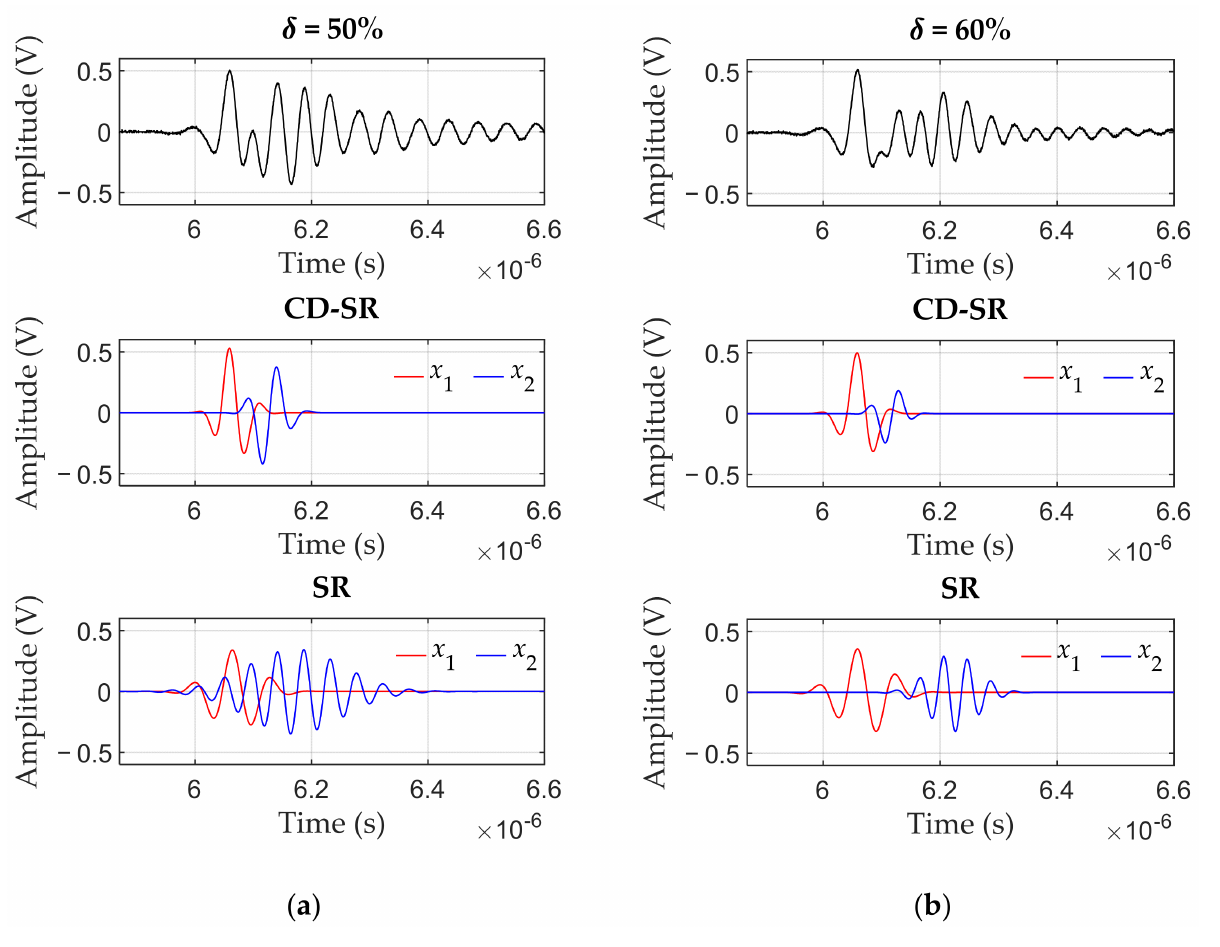
Figure 13. Comparison of reconstructed echoes: ( a ) δ = 50%; ( b ) δ = 60%.